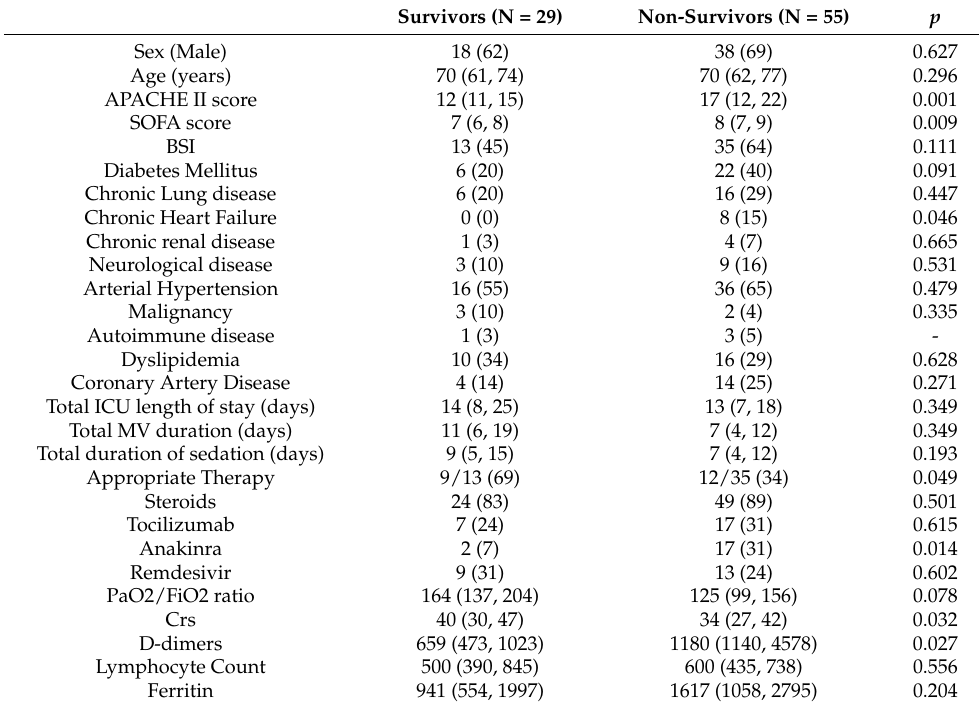
Table 6. Characteristics of survivors and non-survivors in the ICU.